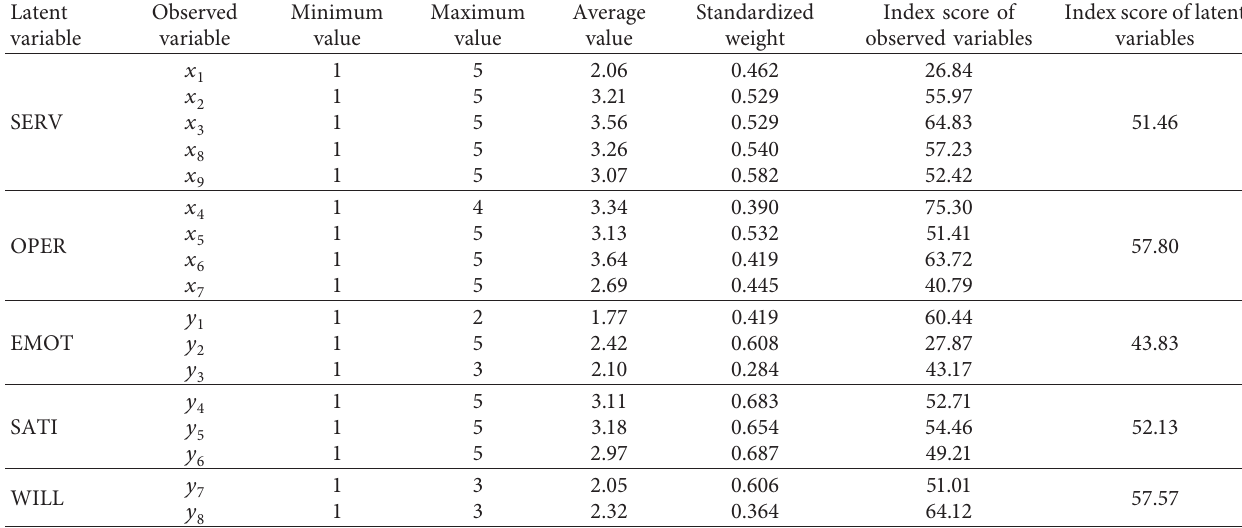
Table 7: Index scores of latent and observed variables.